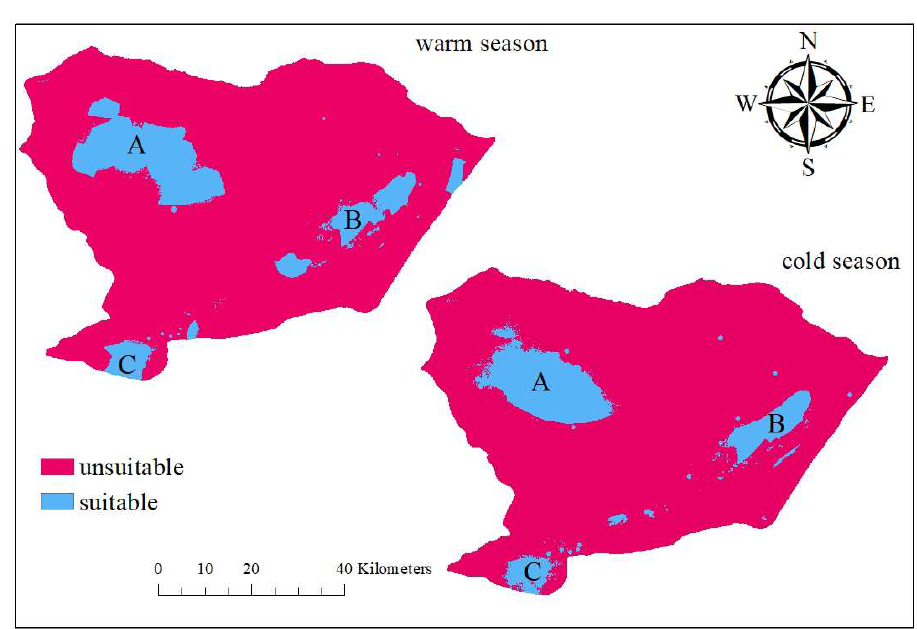
F IGURE 3. Wild goat habitat suitability ensemble maps in the study area.